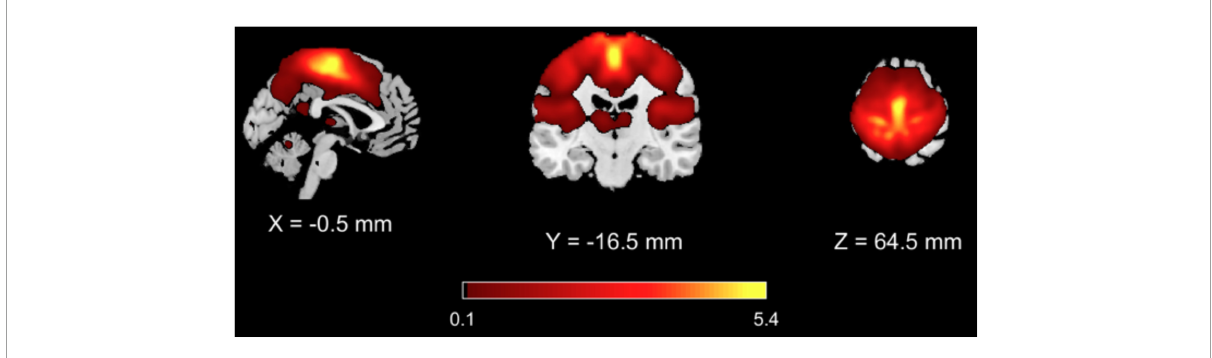
FIGURE1 Results of GICA analysis. The SMN component was selected as the one with highest z values in the primary and supplementary motor areas and in the primary and secondary sensory areas.